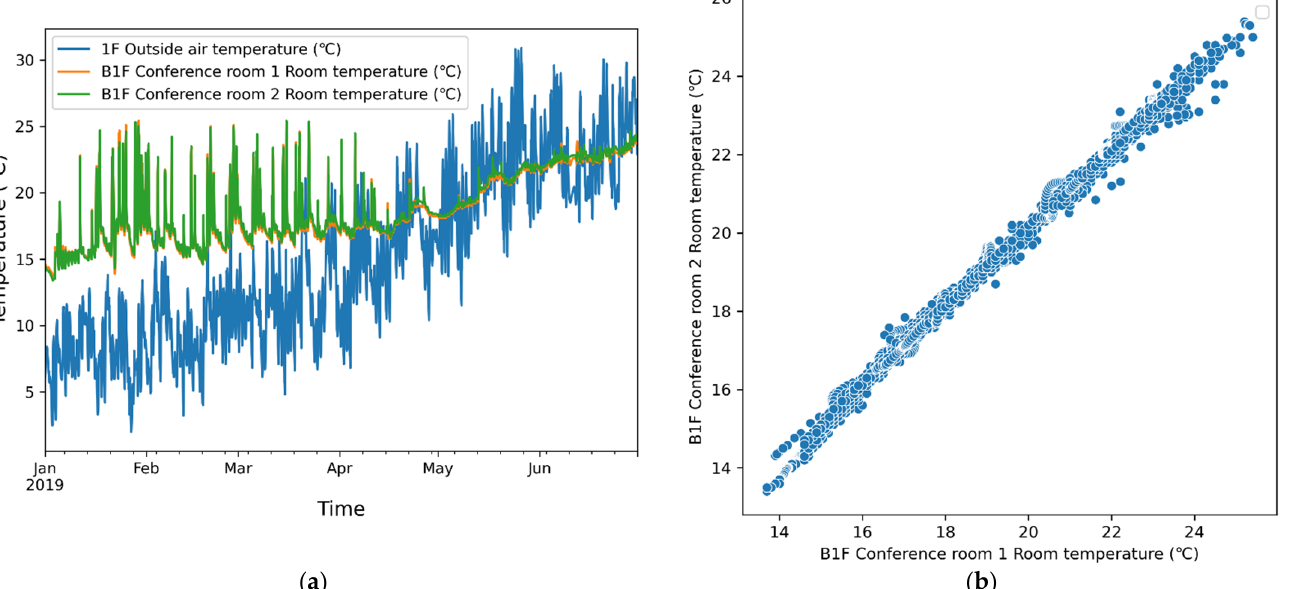
Figure 3. ( a ) Time series plot for outside air temperature, B1F conference room 1 temperature, and B1F conference room 2 temperature; ( b ) scatter plot of B1F conference room 1 temperature and B1F conference room 2 temperature.